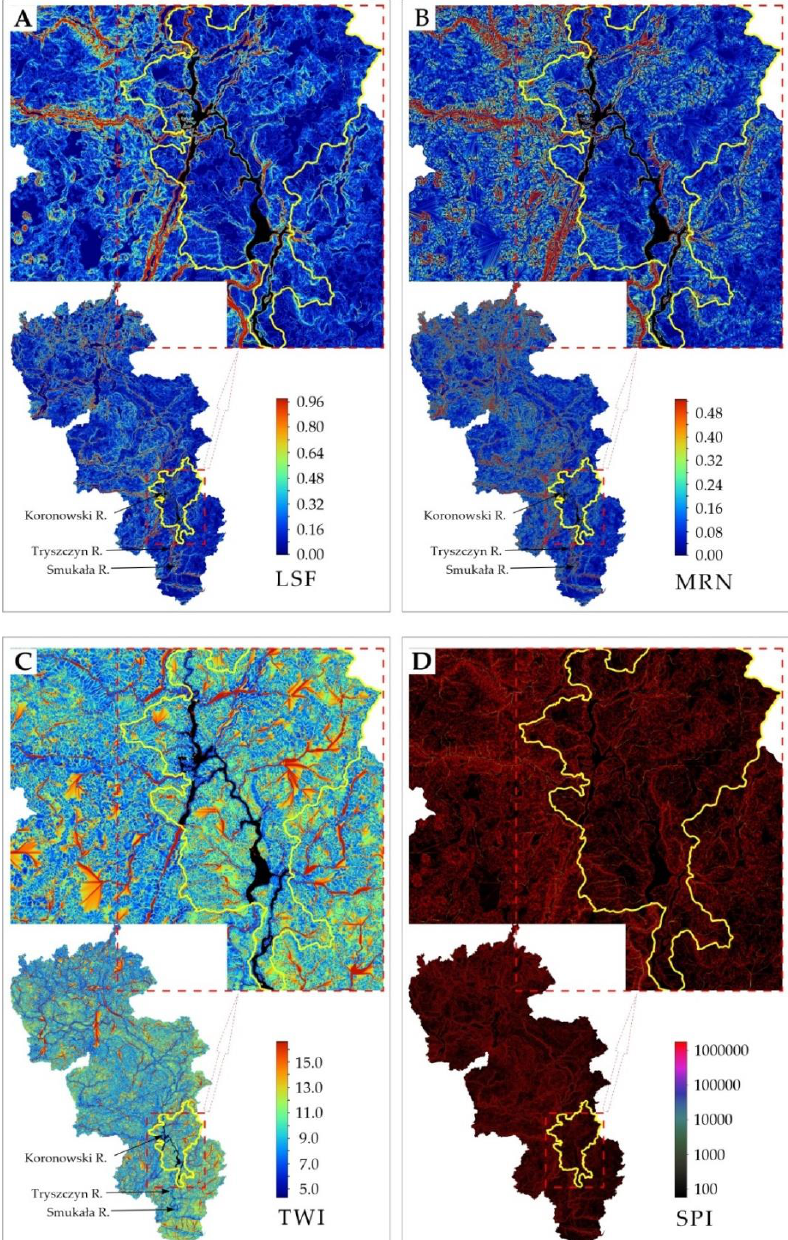
Figure 6. Spatial image of morphometric and physical characteristics of the Brda River catchment, ( A ) LS Factor (LSF), ( B ) Melton Ruggedness Number (MRN), ( C ) Topographic Wetness Index (TWI), ( D ) Stream Power Index (SPI).